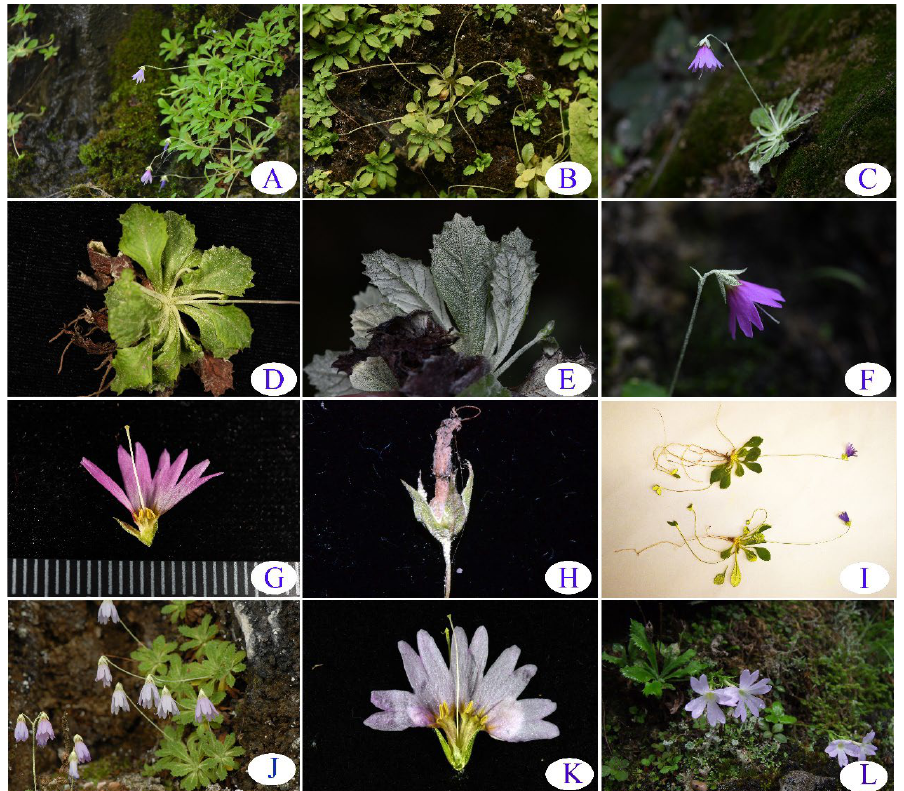
Figure 2. Primula luquanensis sp. nov. and its close species. ( A – I ) P. luquanensis , ( A ) habitat, ( B ) stolons, ( C ) habit, ( D ) upper face of leaves, ( E ) lower face of leaves, ( F ) lateral view of flower, ( G ) dissected corolla showing new floral form, ( H ) calyx and fruit, ( I ) specimens, ( J – K ) Primula nutantiflora : ( J ) habit, ( K ) dissected corolla, ( L ) Primula yunnanensis.